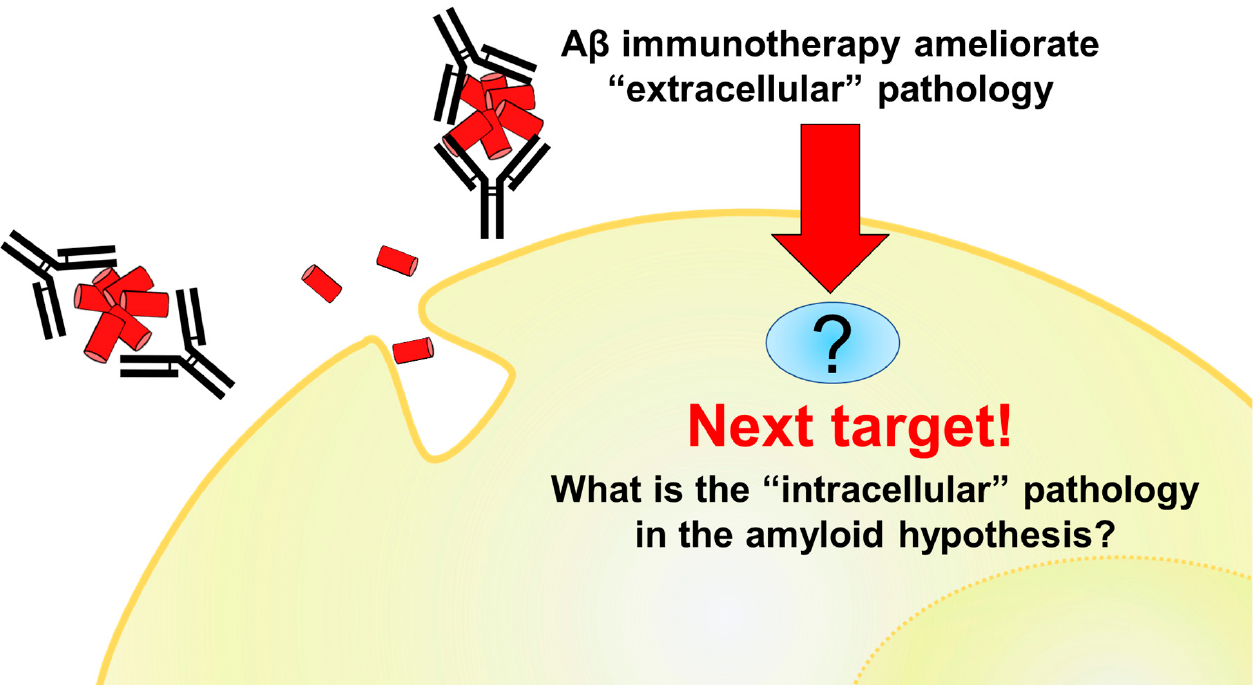
Figure 1. A diagram of the subject of this review. The therapeutic efficacy of antibodies against extracellularly aggregating A β has been demonstrated and is expected to be the first step toward curative treatment of AD. On the other hand, their therapeutic effects are still limited, and it will be necessary to develop treatments from a different perspective. This review outlines the hidden aspect of the amyloid hypothesis: intracellular pathogenesis and its potential as a therapeutic target. A β is produced from a large type-I transmembrane protein, amyloid beta precursor protein (APP). One of the APP metabolites, its 99-aa C-terminal fragment (C99, also called significance of C99 in AD pathogenesis [6,7]. C99 accumulates through the